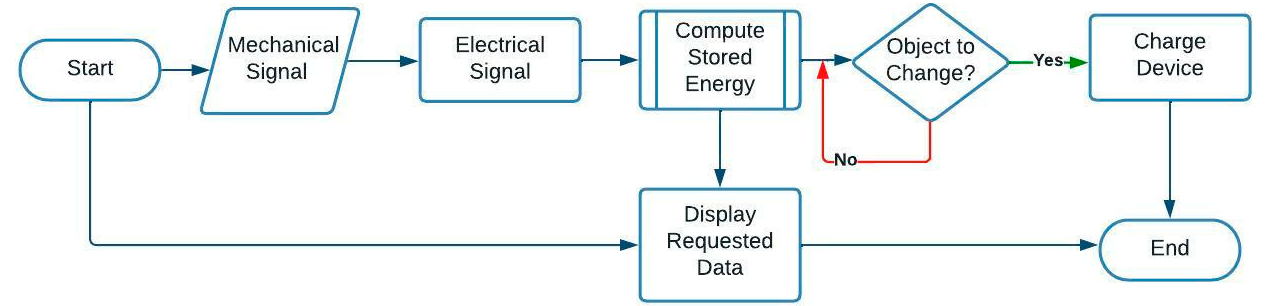
Figure 7. Data Flow Diagram of Wireless Communication.